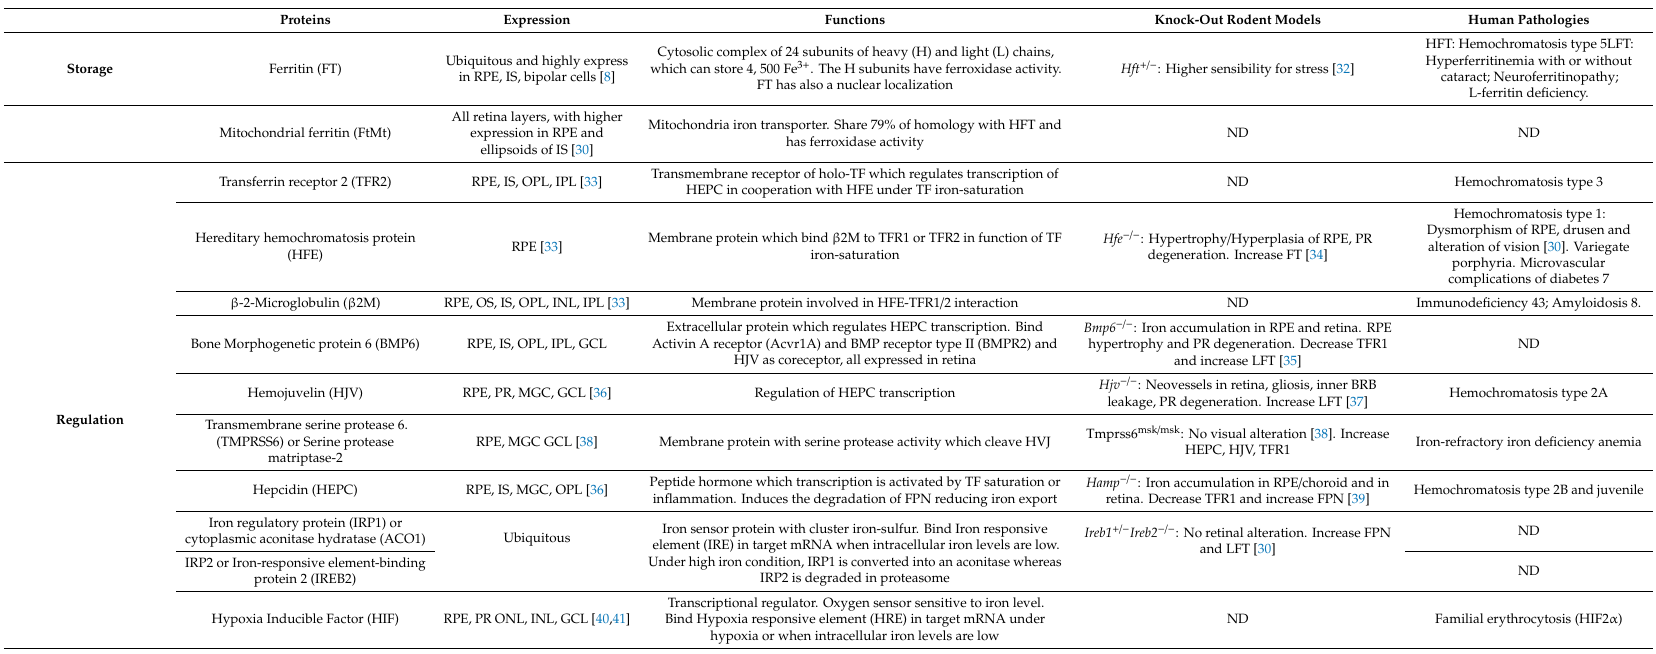
Legend Table 1 : Proteins localization were obtained from immunostaining on sections of mouse / rat retinas. The mouse models presented are limited to those with retinal changes in iron homeostasis and retinal abnormalities, if any. The corresponding human diseases were obtained by searching the UniProt site. ND: Not determined. Legends: β 2M: β -2-Microglobulin; CP: ceruloplasmin; CEC: choroidal endothelial cell; FT: ferritin; GCL: ganglion cells layer; HFE: hereditary hemochromatosis protein, HFT: ferritin heavy chain; IPL: inner plexiform layer; IRE: iron responsive element; IS: inner segments; LFT: ferritin light chain; MGC: Müller’s glial cell; OPL: outer plexiform layer; OS: outer segments; PR: photoreceptor; REC: retinal endothelial cell; RPE: retinal pigment epithelium; TFR1: transferrin receptor